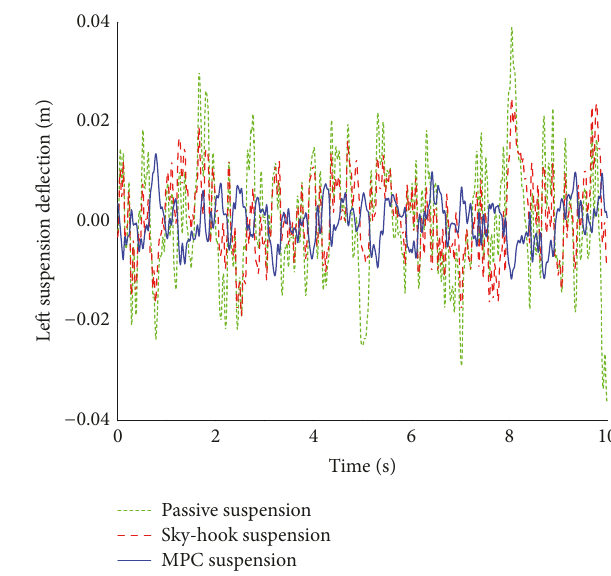
Figure 5: Deflection of the suspension (left).